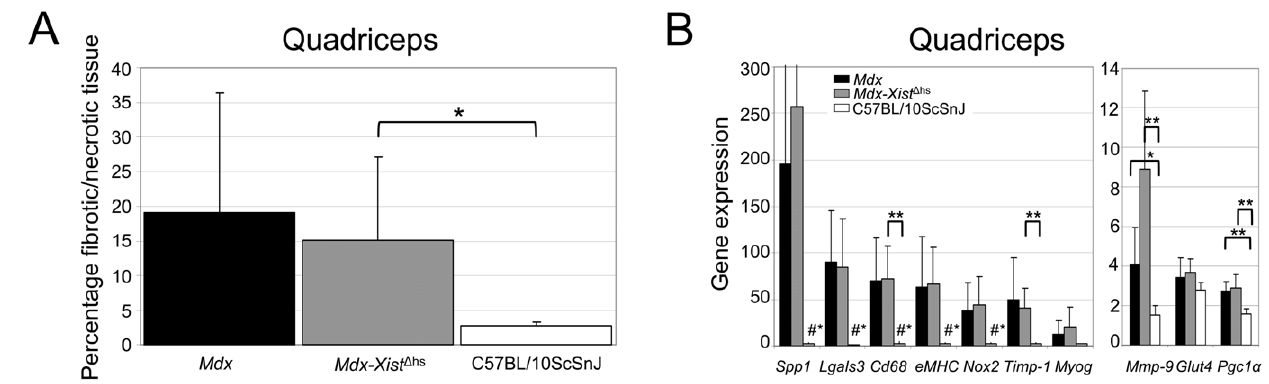
Figure 7. Exercise induced histopathology and biomarker gene expression. A. Wild type mice were less severely affected than mdx and mdx-Xist D hs mice. Due to high variation between individual mdx mice, the difference between mdx and wild type mice was not significant. Mdx-Xist D hs mice had slightly less fibrotic tissue than mdx mice. B. No difference in expression of genes involved in disease pathology was found between mdx and mdx-Xist D hs mice. Both mouse strains did differ significantly from wild type mice, of which the expression levels were low. Single and double asterisks indicate a P , 0.05 and P , 0.01, respectively. # Indicates a significant difference from all other groups, average dystrophin levels of mdx- Xist D hs mice was 21% (2%–45% median 25.8).